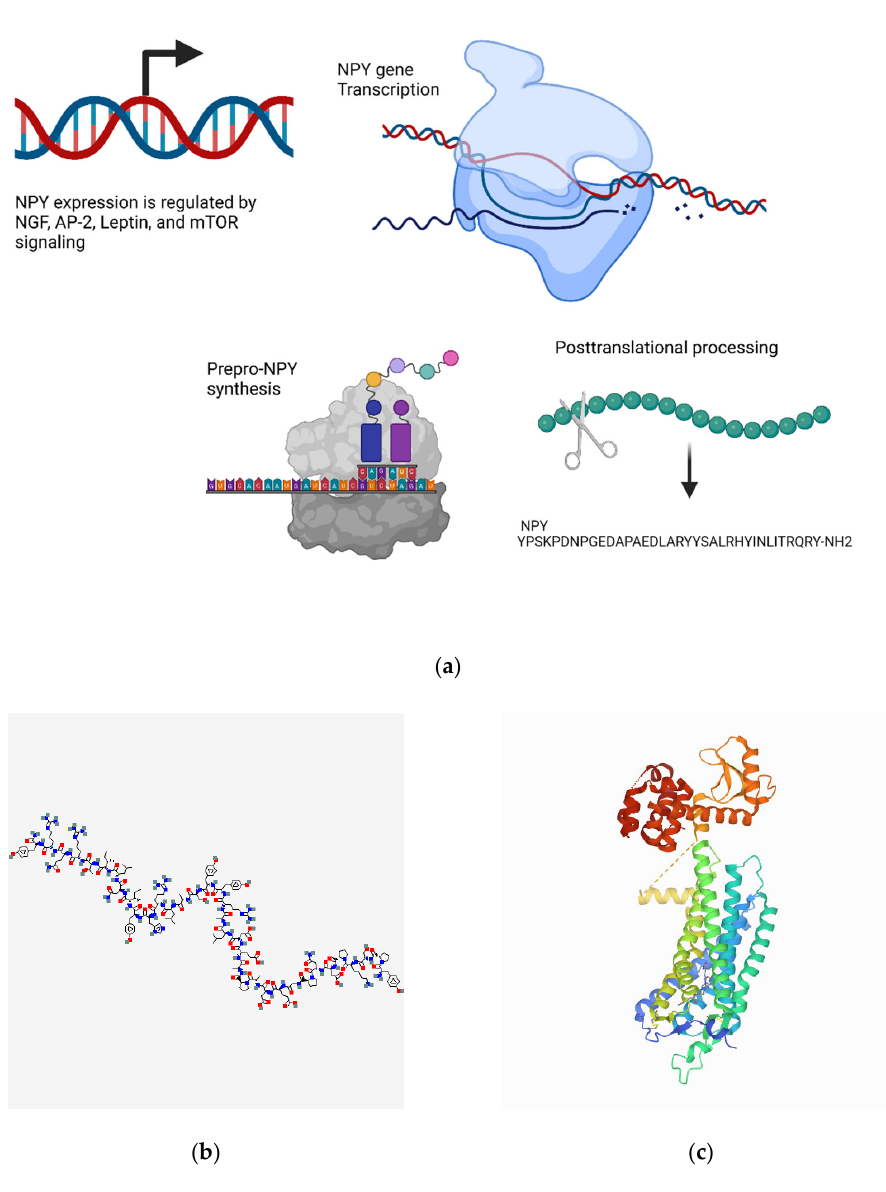
Figure 7. Neuropeptide Y and receptor: ( a ) transcription and synthesis of NPY (created with BioRender.com accessed on 22 October 2021); ( b ) 2D structure image of NPY (https://pubchem.ncbi.nlm.nih.gov/compound/16132350#section=2D-Structure, accessed on 22 October 2021); ( c ) the crystal structure of a human neuropeptide Y Y1 receptor with UR-MK299. Image from the RCSB PDB (rcsb.org) of PDB ID 5ZBQ [451].